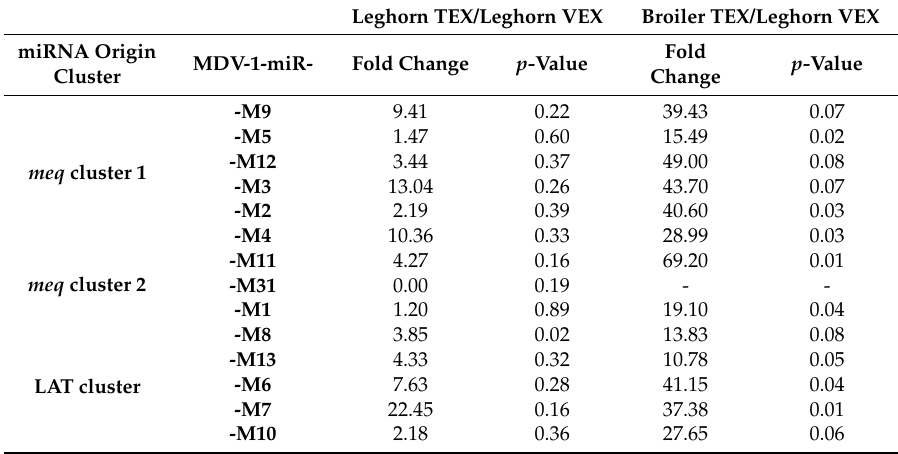
Figure 5. Comparison of MDV-encoded miRNAs in VEX and TEX. Panel ( A ) shows a map of the MDV genome with the location and orientation of the miRNA clusters (Meq cluster 1, 2 and LAT cluster). Panel ( B ) shows the read numbers of the Meq cluster 1 miRNAs in leghorn VEX (top) and TEX (bottom) showing reads for individual chickens. Note differences in y-axes (3000 vs. 35,000). Panel ( C ) shows the Meq cluster 2 (downstream of the meq gene) miRNA reads for leghorn VEX (top) and TEX (bottom). Panel ( D ) shows the individual reads of the LAT cluster of miRNAs from leghorn VEX (top) and TEX (bottom). Table 4. Expression levels of MDV-encoded miRNAs in TEX compared to